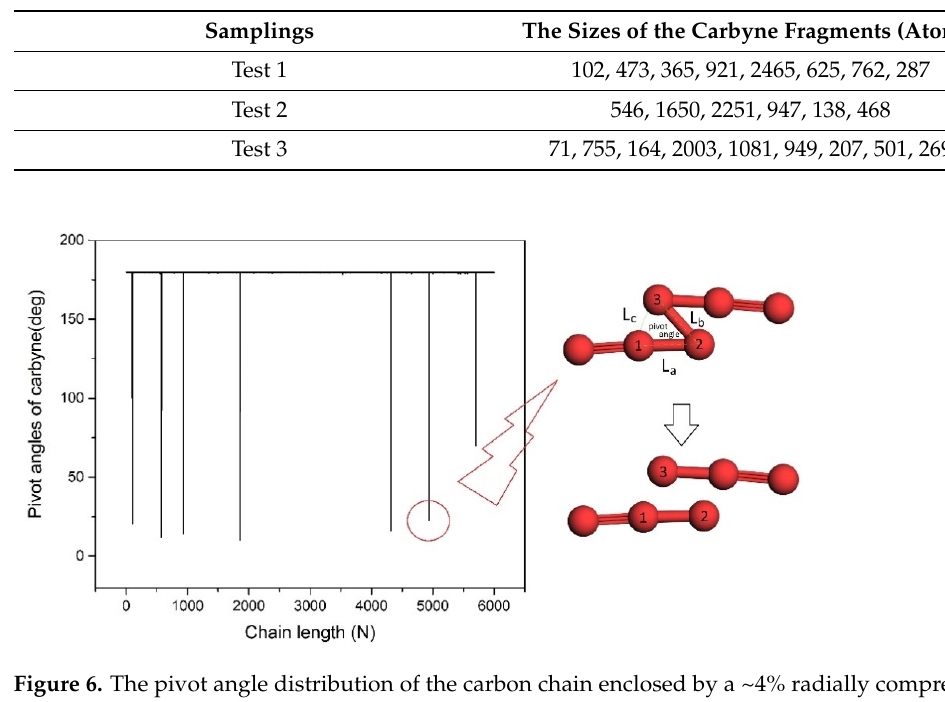
demonstrated in Table 3. The introduction of a tiny amount of vacancy defects is su ffi cient to signi fi cantly shorten the cut-o ff length to N ~ 5600. In Table 4, the cut-o ff length of the